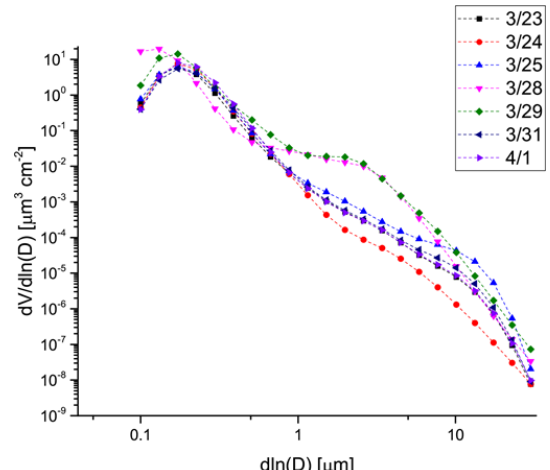
Figure A5. Volumetric size distributions retrieved by the inver- sion algorithm on days prior to (23, 24, and 25 March), during (28 and 29 March), and after (31 March and 1 April) the arrival of the Caspian dust at the Venice AERONET site. (Please note that dates are displayed using a month/day format in this